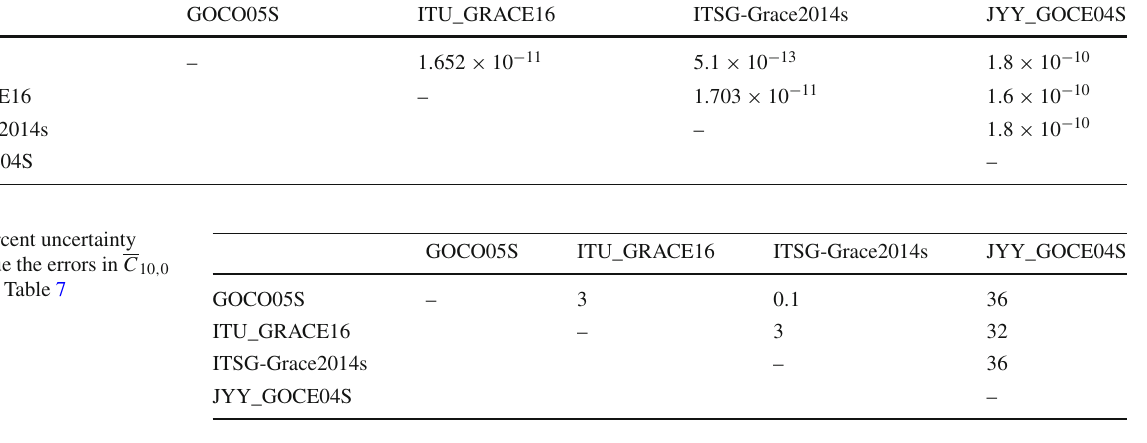
Table 7 Absolute values of the differences (cid:6) C 10 , 0 among the esti- mated values C 10 , 0 of the models of Table 2. They are very close to the uncertainties retrievable from the application of Eq. (A11) by Wagner